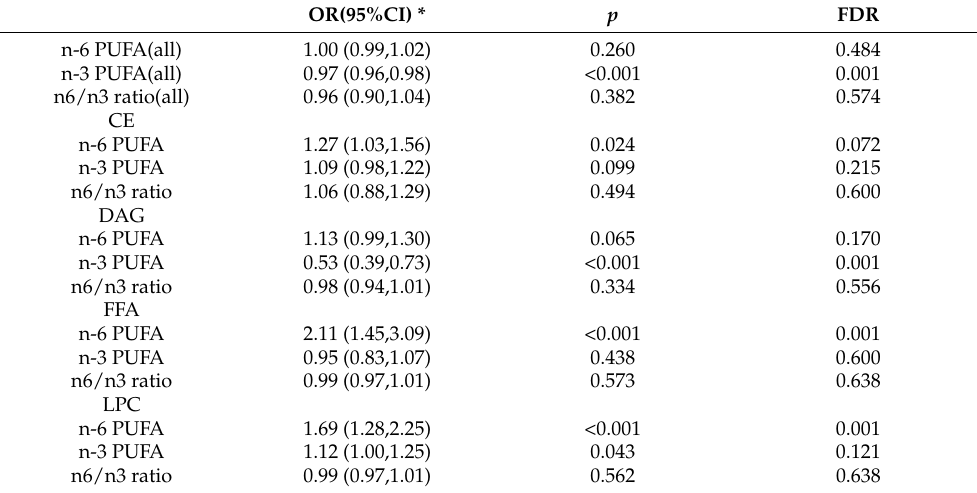
Table 2. Relationship between polyunsaturated fatty acids among subclass and the risk of